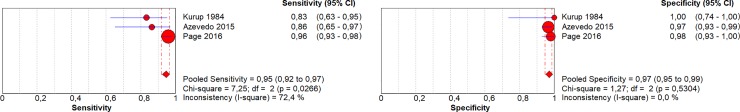
Forest plot of sensitivity (A), specificity (B), and heterogeneity from the ELISA test for the subgroup analyses (three studies with healthy controls).